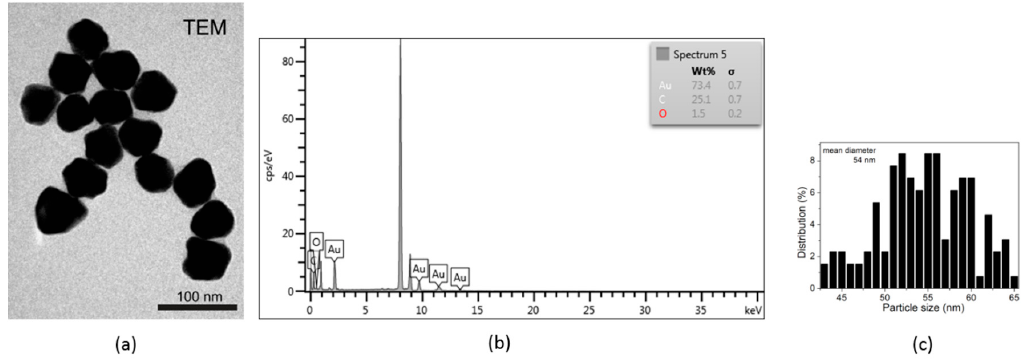
Figure 2. ( a ) TEM micrographs of the colloidal AuNPs (scale bar 100 nm); ( b ) EDS spectrum of the AuNPs; ( c ) particle size distribution from TEM.